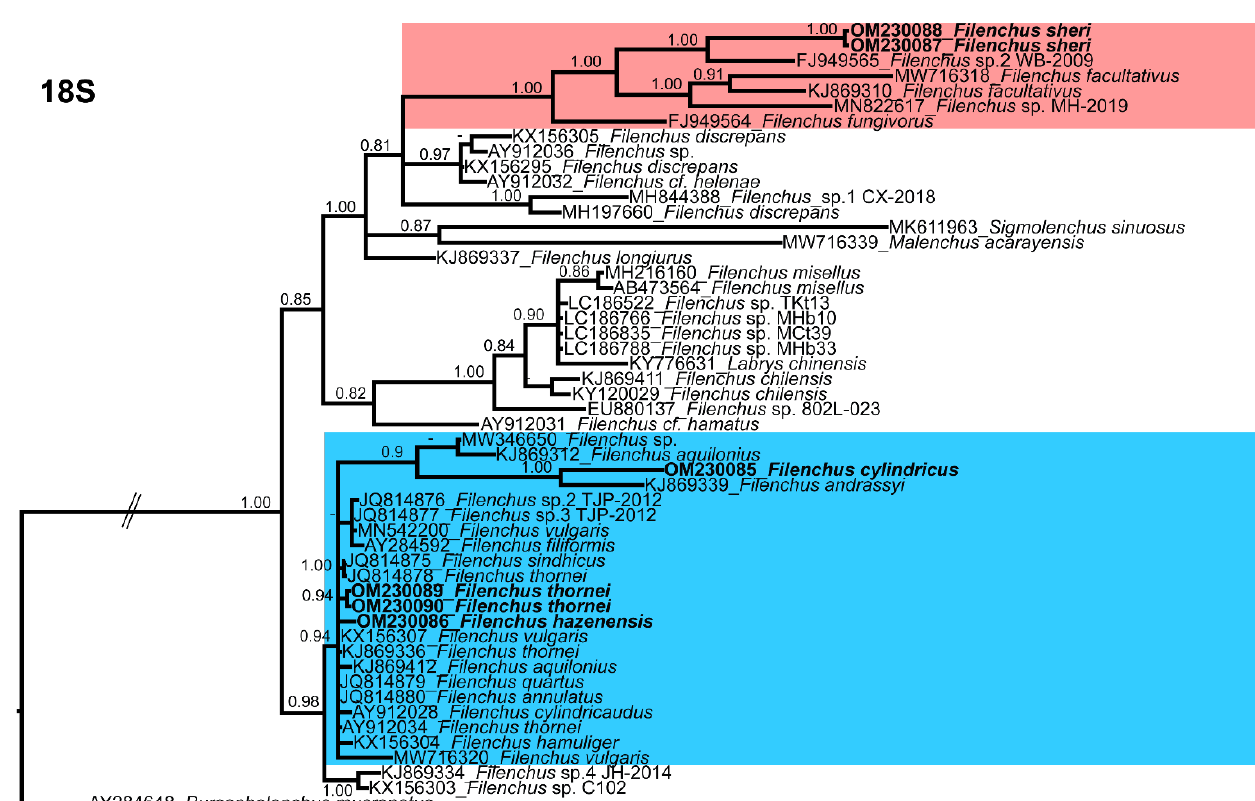
Figure 5. Phylogenetic relationships of the Canadian population of Filenchus species with related Tylenchidae species. Bayesian 50% majority rule consensus tree as inferred from 18S rRNA sequence alignment under the general time-reversible model with invariable sites and a gamma-shaped distribution (GTR + G + I). Posterior probabilities of more than 0.70 are given for appropriate clades. The sequences produced in this study are shown in bold, and the colored boxes indicate the clade association of recovered Filenchus species.